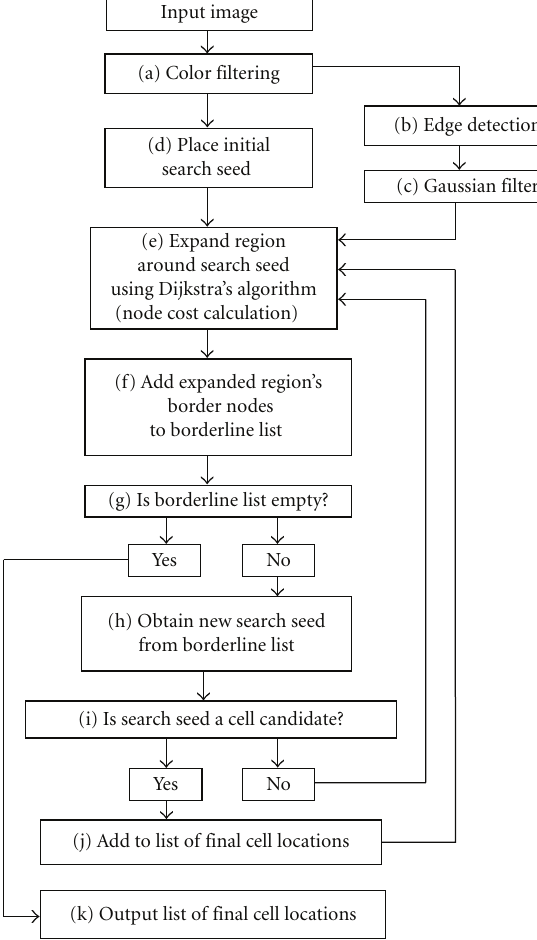
Figure 2: ICS overview